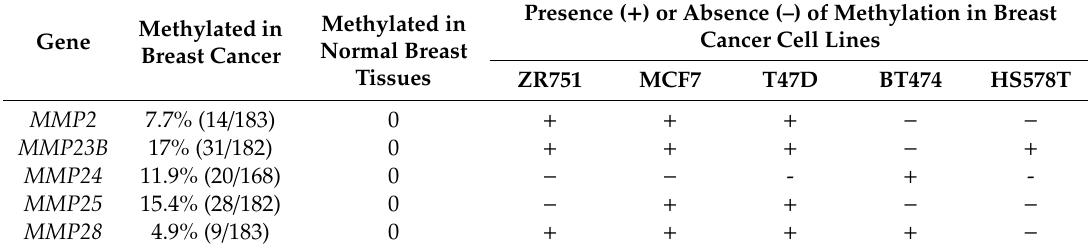
Table 2. Matrix metalloproteinases genes with promoter 5’-cytosine-phosphate-guanine-3’ (CpG) dinucleotides di ff erentially methylated in breast